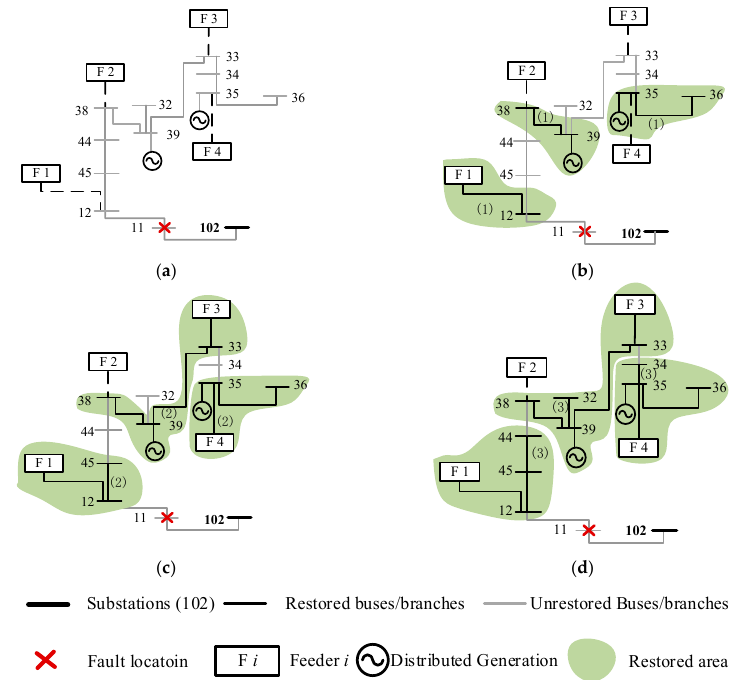
Figure 2. The illustration of parallel power supply restoration. ( a ) System topology before restoration ( b ) 1st step of load restoration; ( c ) 2nd step of load restoration; and ( d ) 3rd step of load